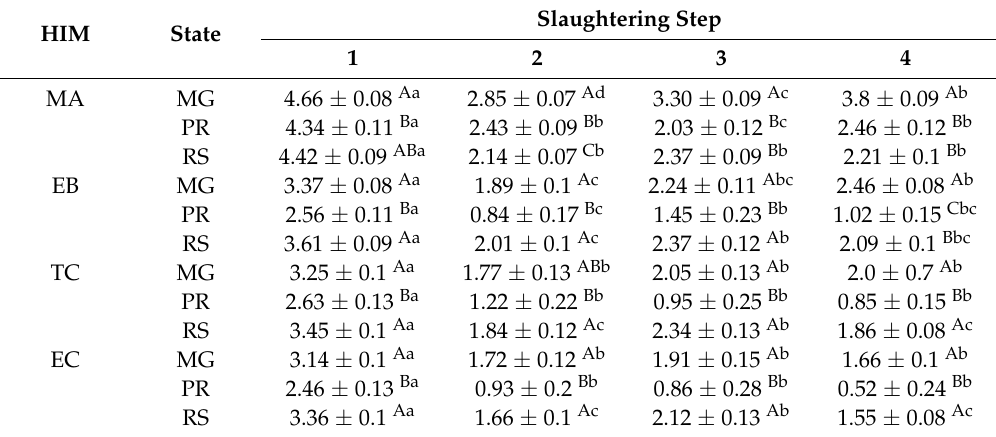
Table 3. Mean counts (log CFU/cm 2 ± SD) of hygiene indicator microorganisms (HIM) in samples collected at four steps of the slaughtering process, in slaughterhouses located in the states of Minas Gerais (MG), Paran á (PR) and Rio Grande do Sul (RS), Brazil.